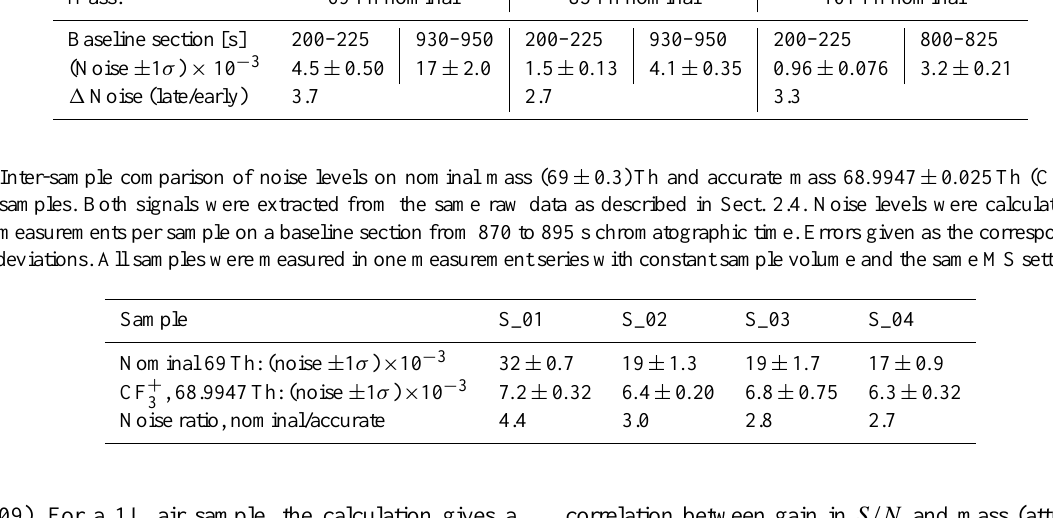
Table 3. Intra-sample comparison of noise levels on three typical halocarbon ion masses (nominal mass intensities). For each ion mass, two baseline sections were chosen for noise calculation, at the beginning and towards the end of the chromatogram. Noise levels and according 1 σ standard deviations were determined over 40 chromatograms measuring the same reference gas and constant sample volume of 0.66L. The (cid:49) Noise row shows noise on late baseline section divided by noise on early baseline section.